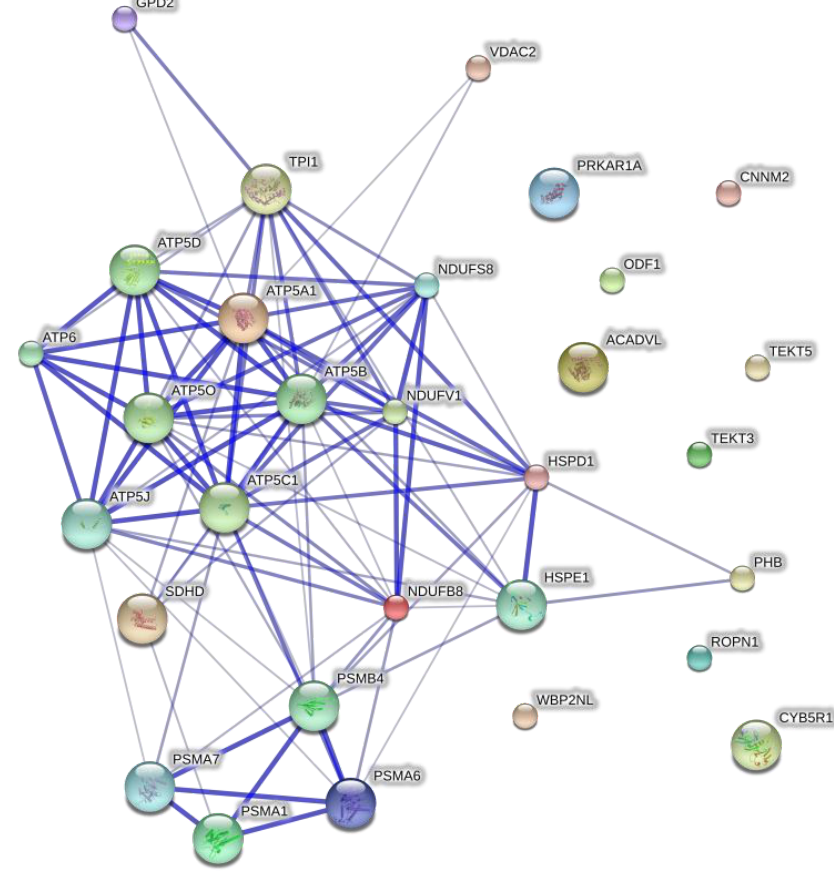
Figure 4. STRING interaction network showing the association between differentially expressed proteins. The interaction map was generated using default settings (Medium confidence of 0.4 and 7 criteria for linkage: neighbourhood, gene fusion, co-occurrence, co-expression, experimental evidences, existing databases and text mining). Ten additional interplay proteins were also added to each network. The protein names and gene symbols used in this network are listed in Table